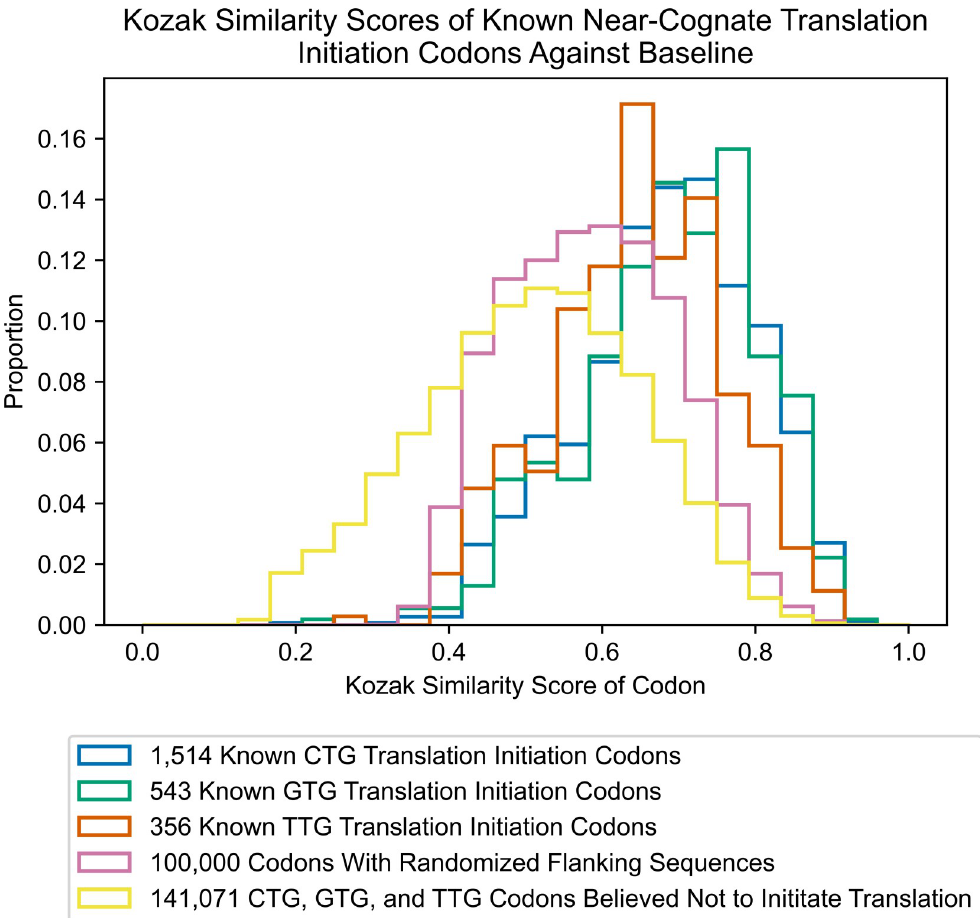
Fig 3. Kozak similarity scores of near-cognate translation initiation codons against